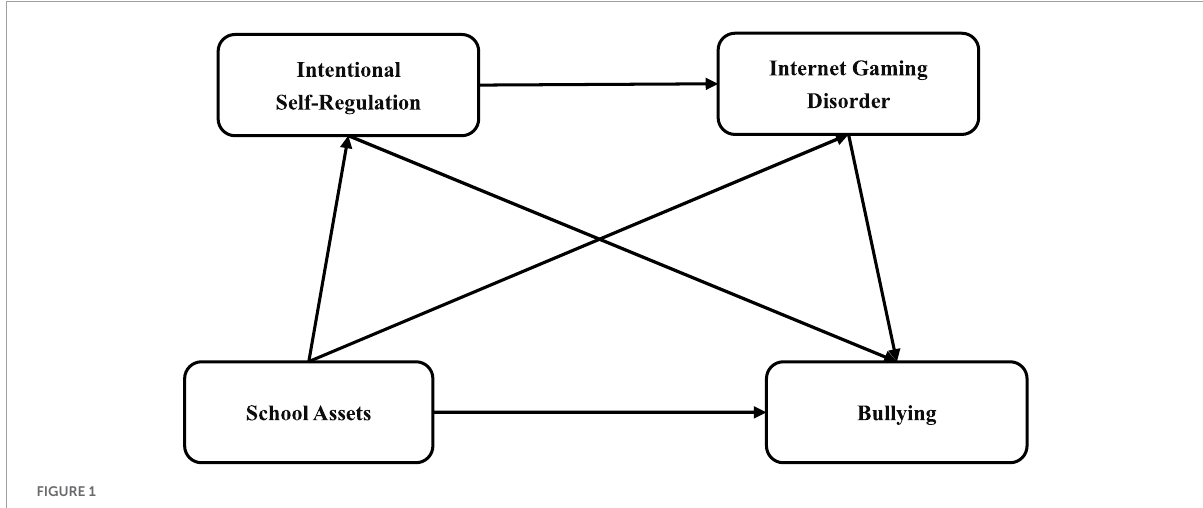
FIGURE1 The conceptual multiple mediation